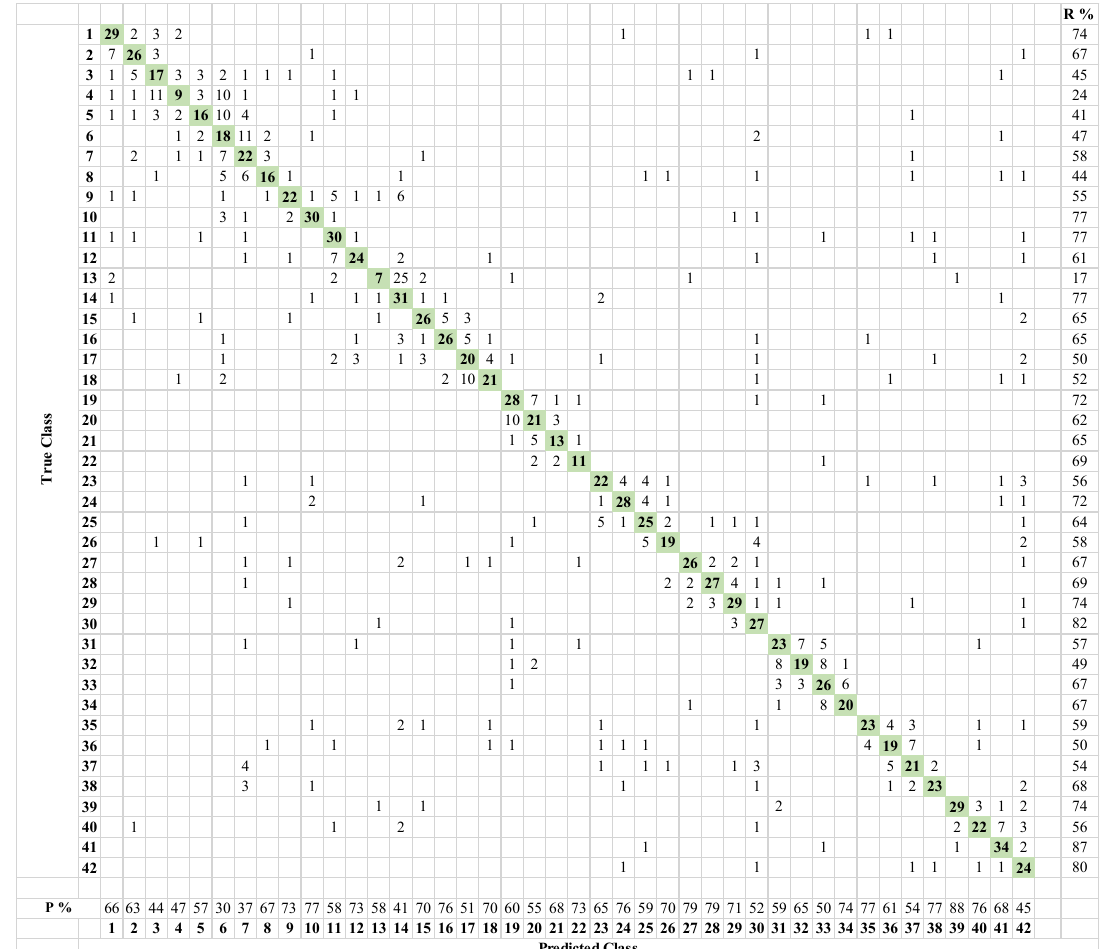
Figure 11. Test confusion matrix of SqueezeNet on 10% of original data set, 60.95% test classification accuracy. (1: normal; 2–8: unbalance with (6, 10, 15, 20, 25, 30, 35) g mass; 9–12: horizontal misalignment of (0.5, 1, 1.5, 2) mm; 13–18: vertical misalignment of (0.51, 0.63, 1.27, 1.4, 1.78, 1.9) mm; 19–22: overhung position ball fault with (0, 6, 20, 35) g unbalance; 23–26: overhung position cage fault with (0, 6, 20, 35) g unbalance; 27–30: overhung position outer race fault with (0, 6, 20, 35) g un-balance; 31–34: underhung position ball fault with (0, 6, 20, 35) g unbalance; 35–38: underhung position cage fault with (0, 6, 20, 35) g unbalance; 39–42: underhung position outer race fault with (0, 6, 20, 35) g unbalance) (R: Recall, P: Precision).